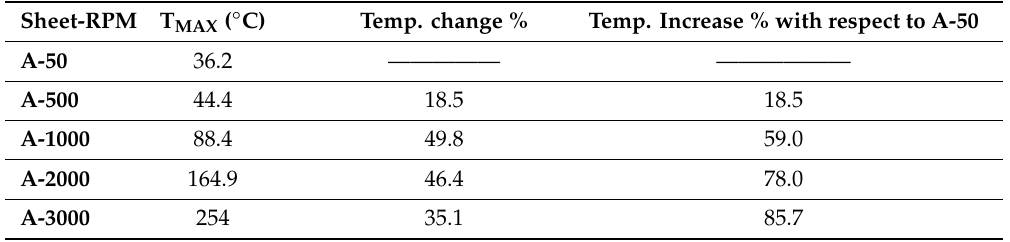
Table 3. Maximum temperature rises during ISF of annealed samples and percent increase in maximum temperature at varying tool rotation.